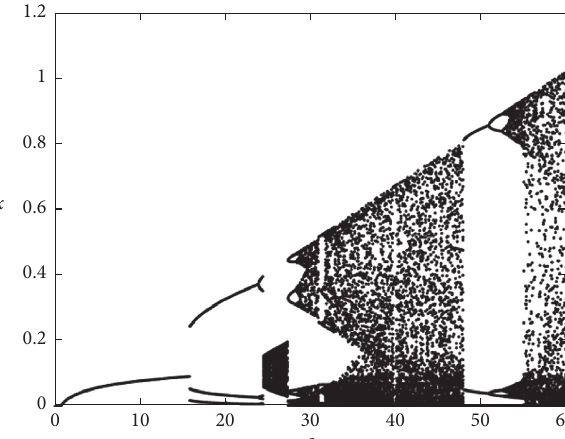
Figure 1: Bifurcation diagrams of equation (3) ( c � 0 . 8 , β � 22, b � 0.7, and 0 < a <